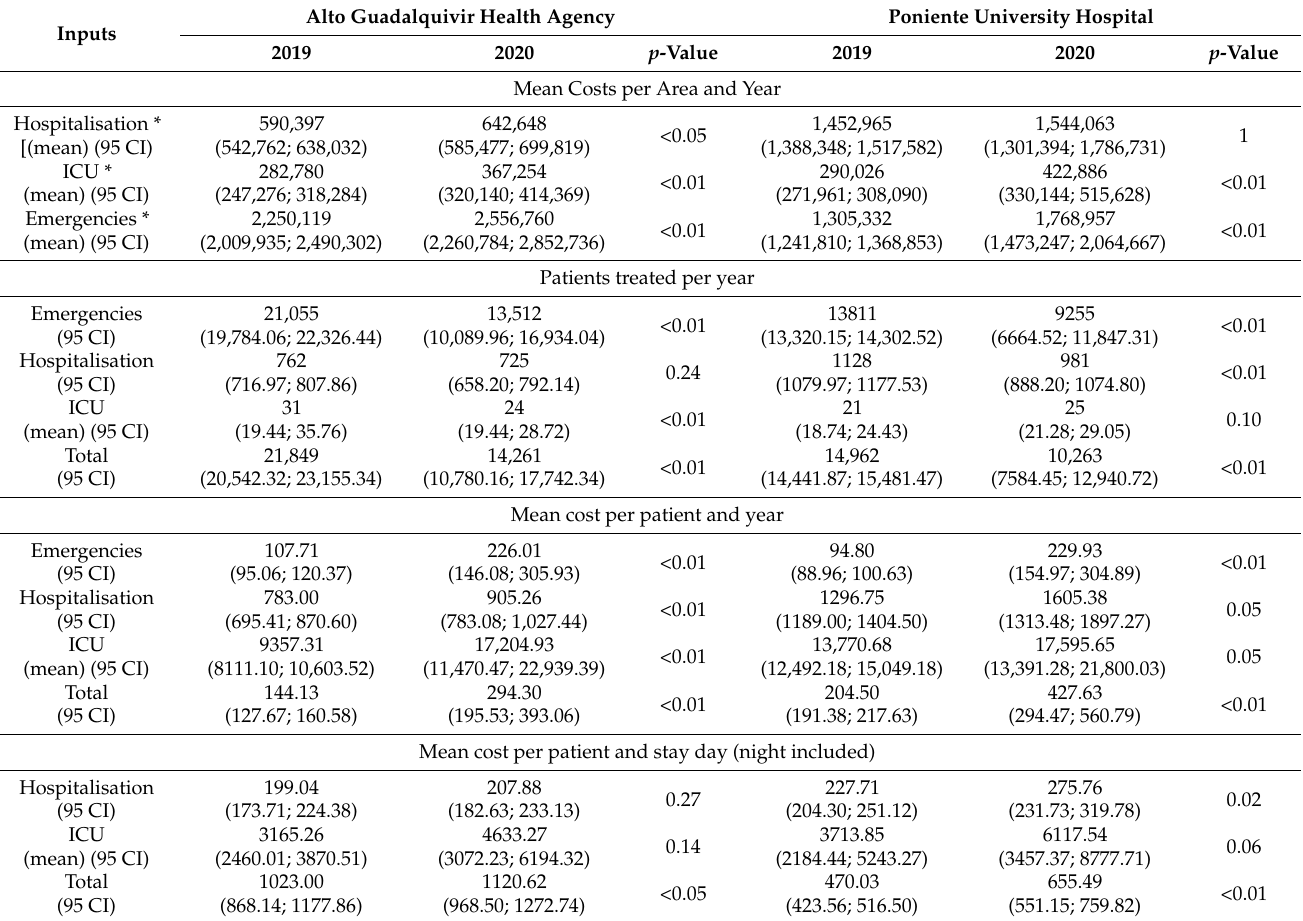
Table 2. Descriptive statistics of costs by area and year for both